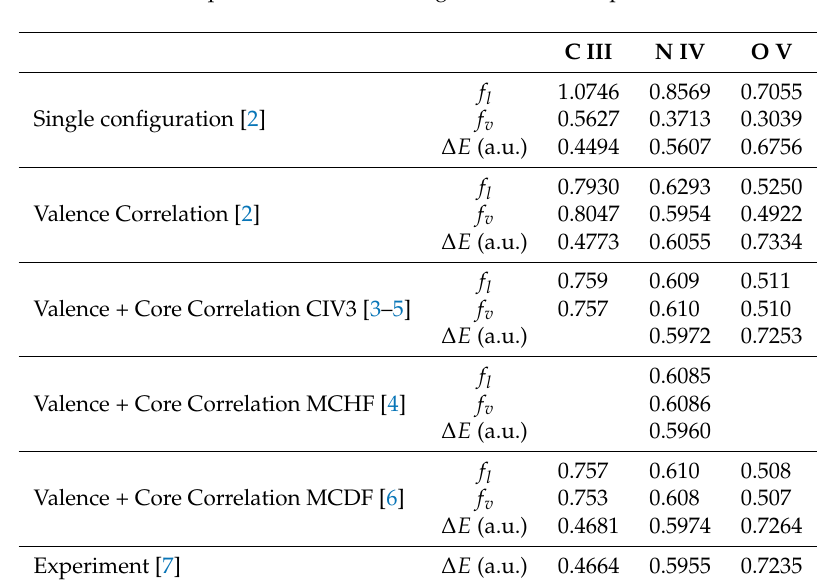
Table 1. Be sequence: Oscillator strengths of 2s 2 1 S–2s2p 1 P o